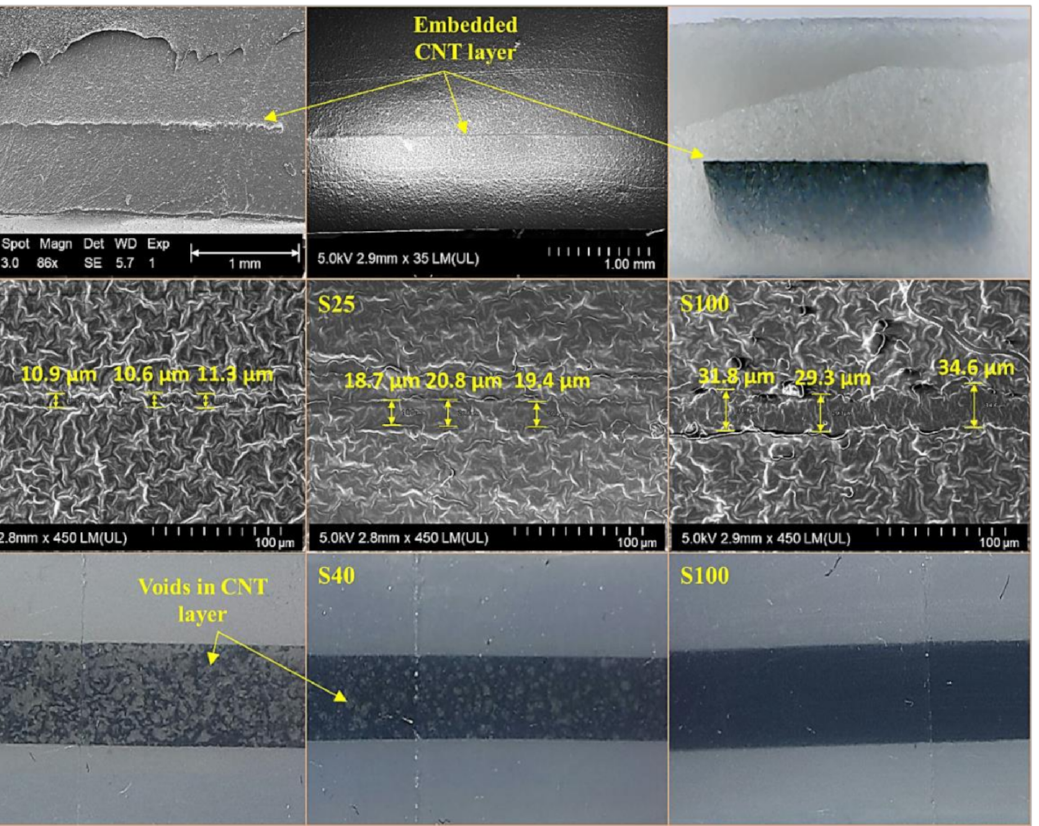
Figure 2. Image analysis of CNT layer-embedded